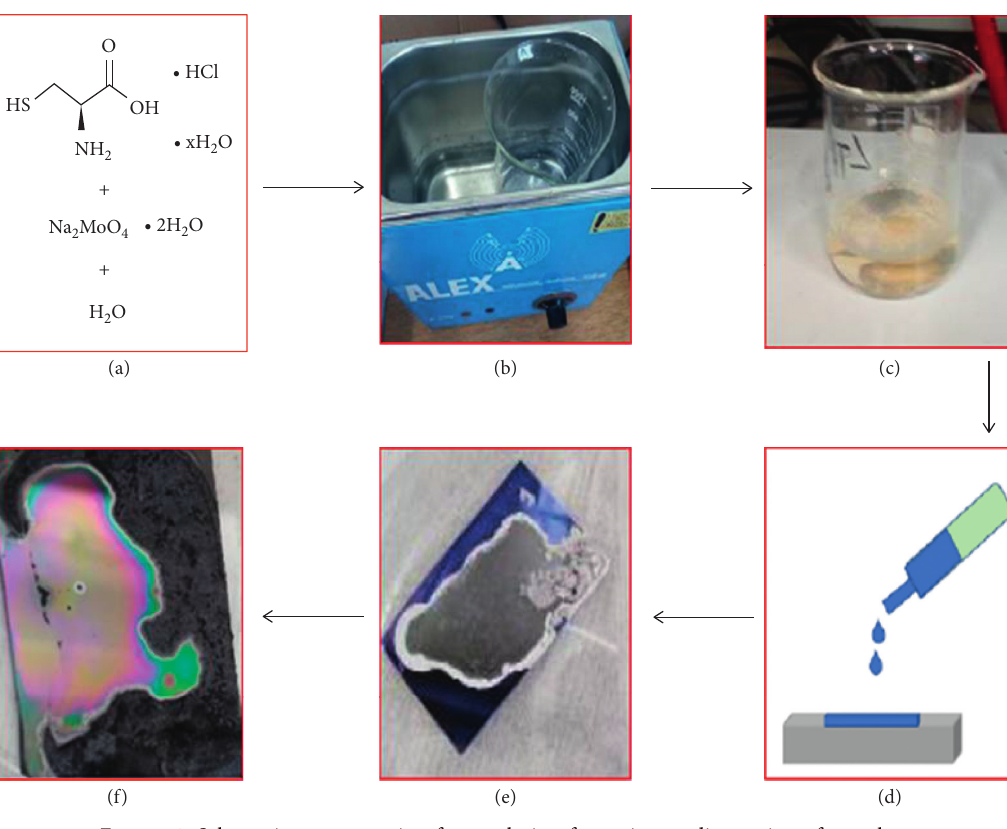
Figure 1: Schematic representation from solution formation to dip coating of samples.